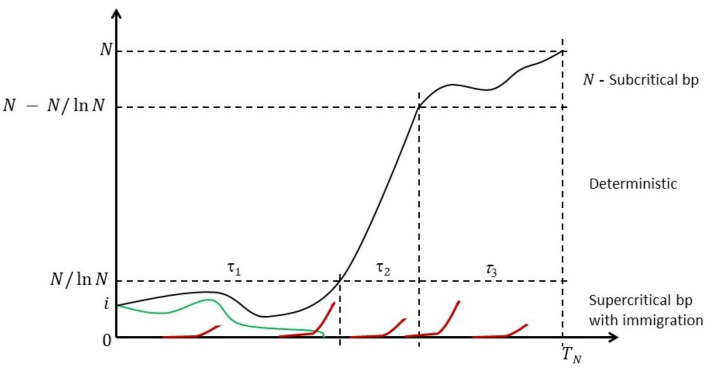
Anatomy of the Moran process with recurrent mutations. Some mutant count trajectories may become transiently extinct (green line), but they will be resurrected by one of the recurring mutations events (red lines). Eventually the mutants are fixed.